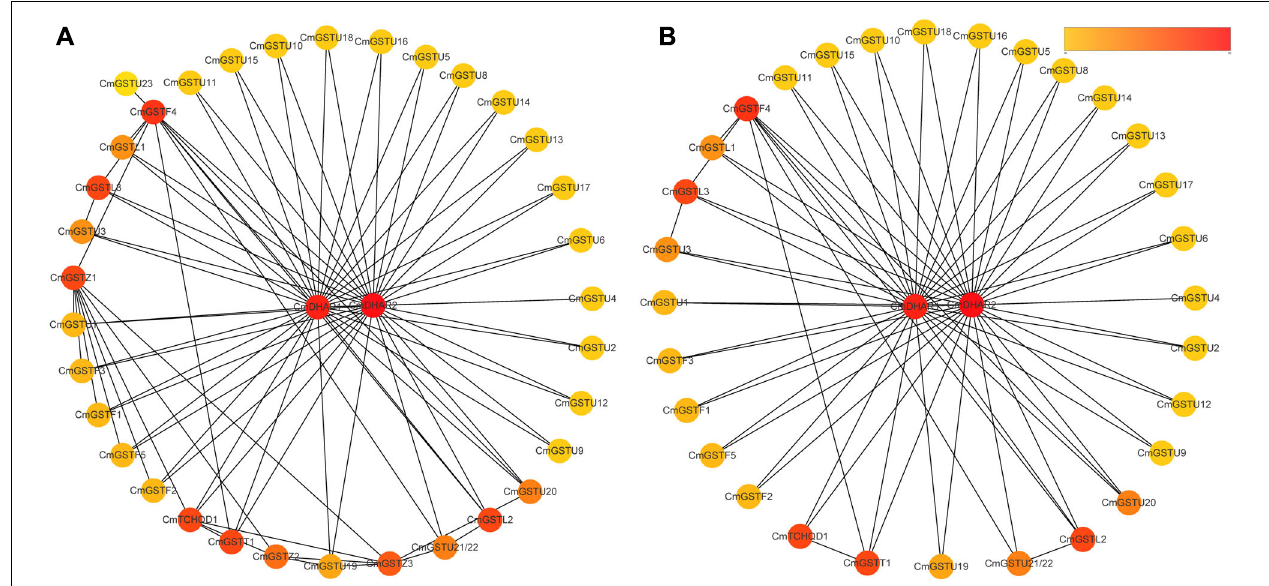
FIGURE 5 | Protein–protein interactions networks of CmGST proteins. (A) PPI networks of 37 CmGST proteins. (B) PPI networks between two CmDHAR proteins and other members of CmGST proteins. Networks were ranked by the MCC method. The score was represented by a yellow-red gradient color: Yellow nodes indicate a low score, and red nodes indicate a high